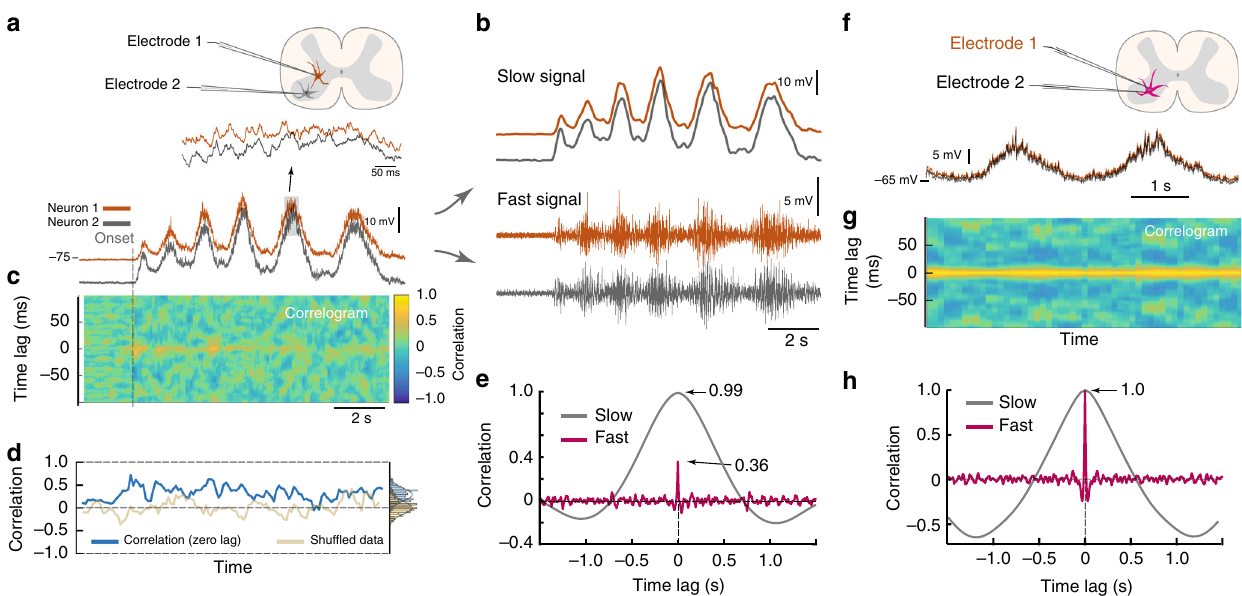
Fig. 4 Two timescales of synaptic input. a Sample data of recordings of two spinal neurons kept hyperpolarized to prevent spiking during network activity (onset indicated, pair from Fig. 3c). Highlighted region indicates concurrent membrane potentials. b Separating traces into slow (top) and fast signals (bottom) by digital fi ltering. c Common synaptic input is quanti fi ed by the correlation of the fast signal in a temporal window (400 ms) moving in time, i.e. correlogram with time on x- – axis, time – lag on y- – axis. A small albeit signi fi cant correlation is seen as a yellow horizontal shadow. d The zero – lag correlation (blue) indicates no clear temporal relation to the rhythm. Distribution shown vertically (right, μ = 0.29). Shuf fl ed data (beige). e Strong slow correlation (0.99), whereas the fast is weak (0.36, excluding quiescence), indicating a decoupling between slow rate modulation and fast synaptic input. f Paired recording from same cell as control. g Correlogram for same – cell dual recordings similar to c . h Same – cell recording show coupling between slow and fast correlation (both peak at 1)